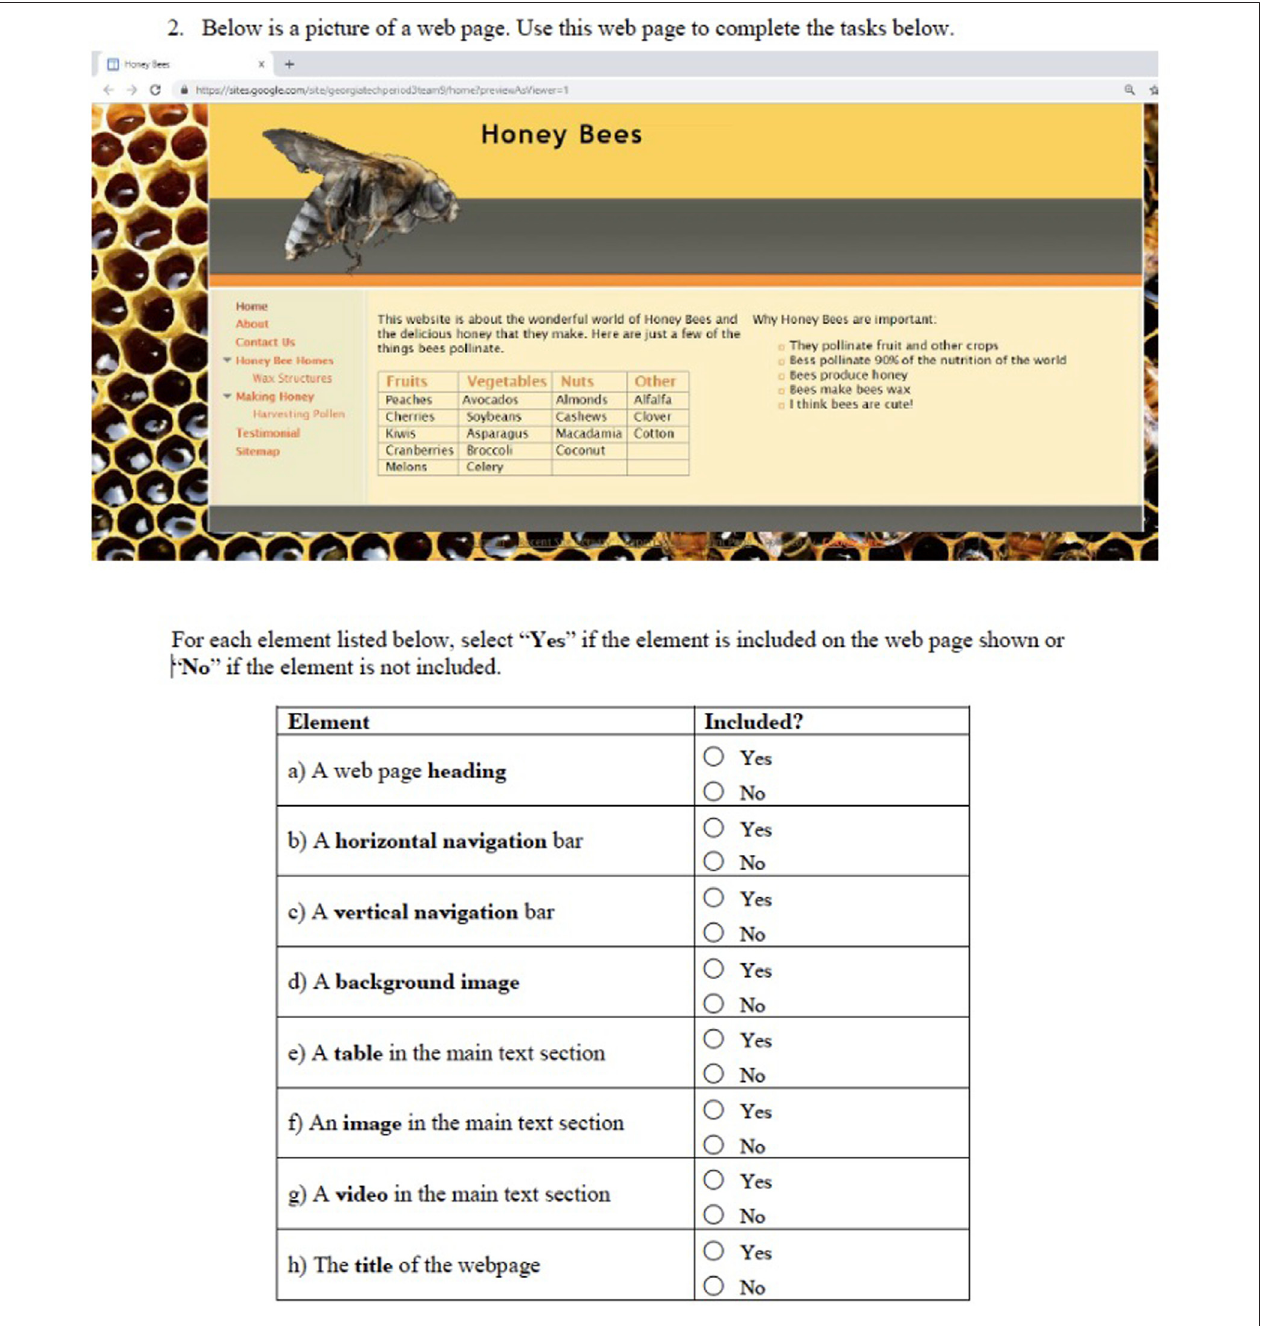
FIGURE 2 | Sample item: Unit 2 assessment, item